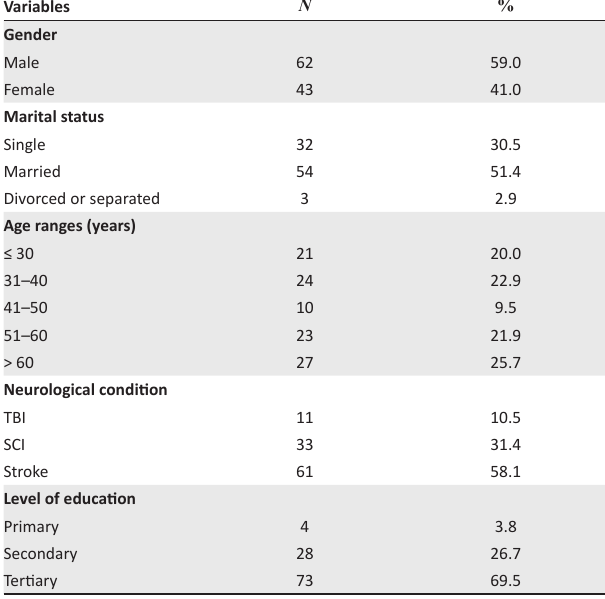
TABLE 1: Socio-demographic and clinical characteristics of participants ( n =